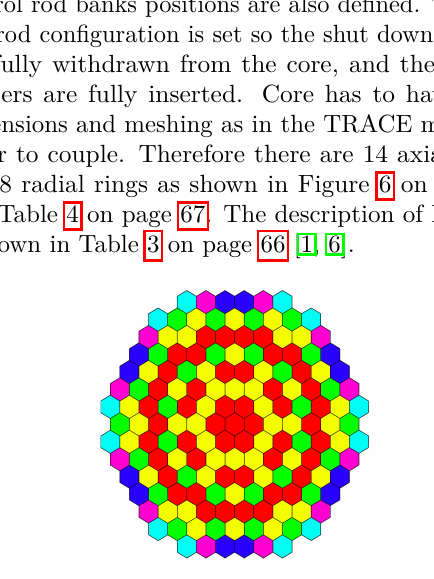
Figure 6. Core layout.